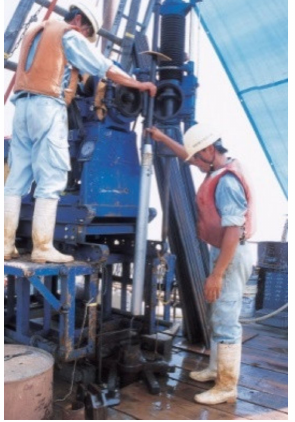
Figure 6. Core boring machine.